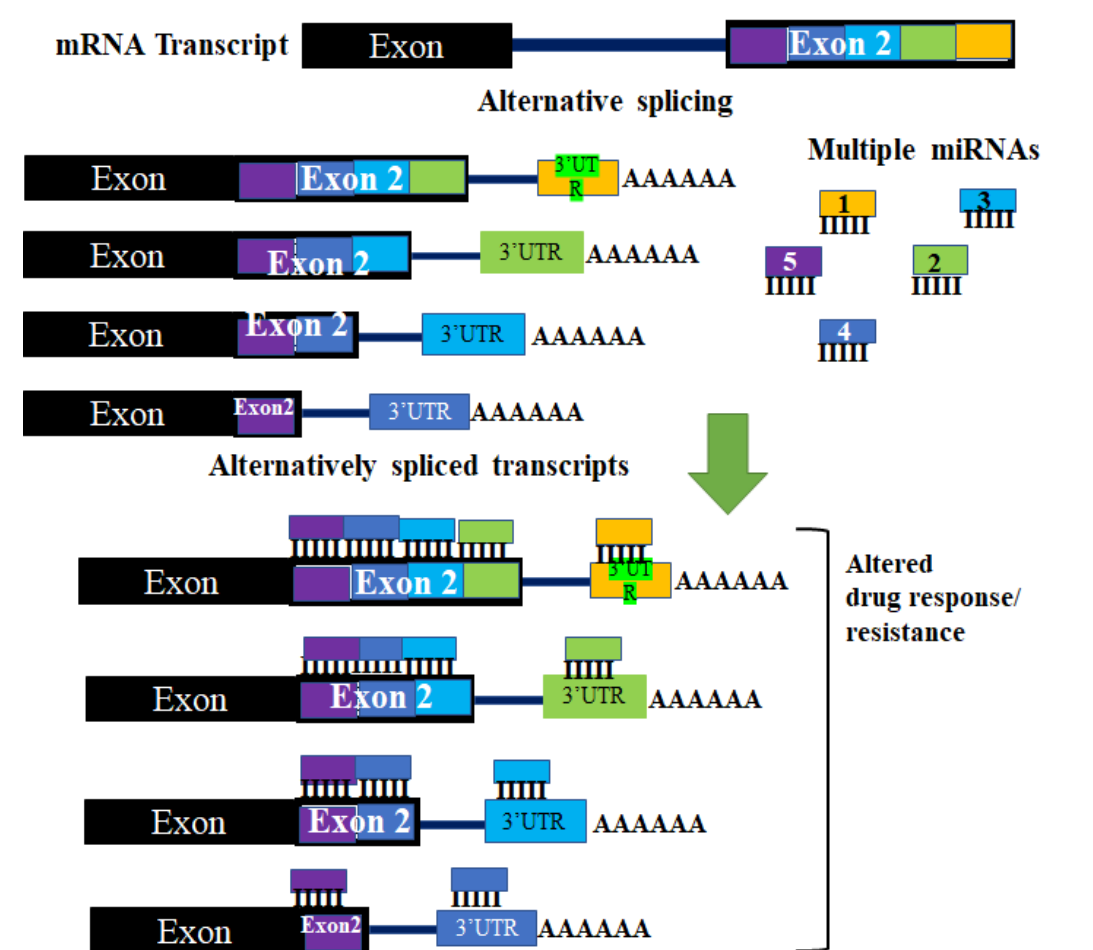
Figure 2. The effect of aberrant alternative splicing in miRNA regulation. Changes in the 3 ′ UTR of target mRNA occur due to different polyadenylation sites. The different 3 ′ UTRs that result have different regions where miRNAs can bind and target the mRNA. These changes can result in some miRNAs not being able to regulate different alternatively spliced transcripts of the same pre-mRNA. These changes can affect regulation by miRNAs. This may lead to changes in cellular effectors (such as proteins and enzymes) of drug resistance, thereby altering a tumor’s response to a drug.